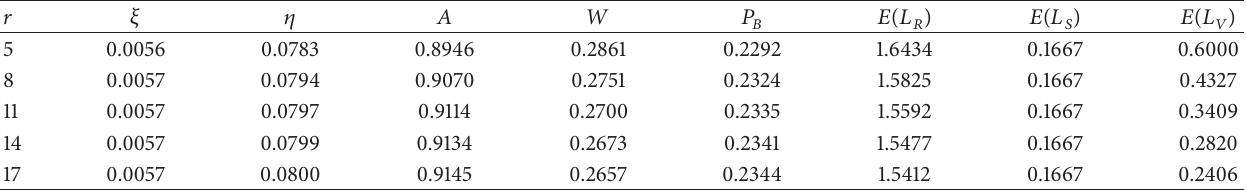
Table 2: Main reliability indices of production line for different part-time job rate 𝑟 with (𝜆,𝜃, 𝛼,𝛽) = (3, 6,0.35, 14) .